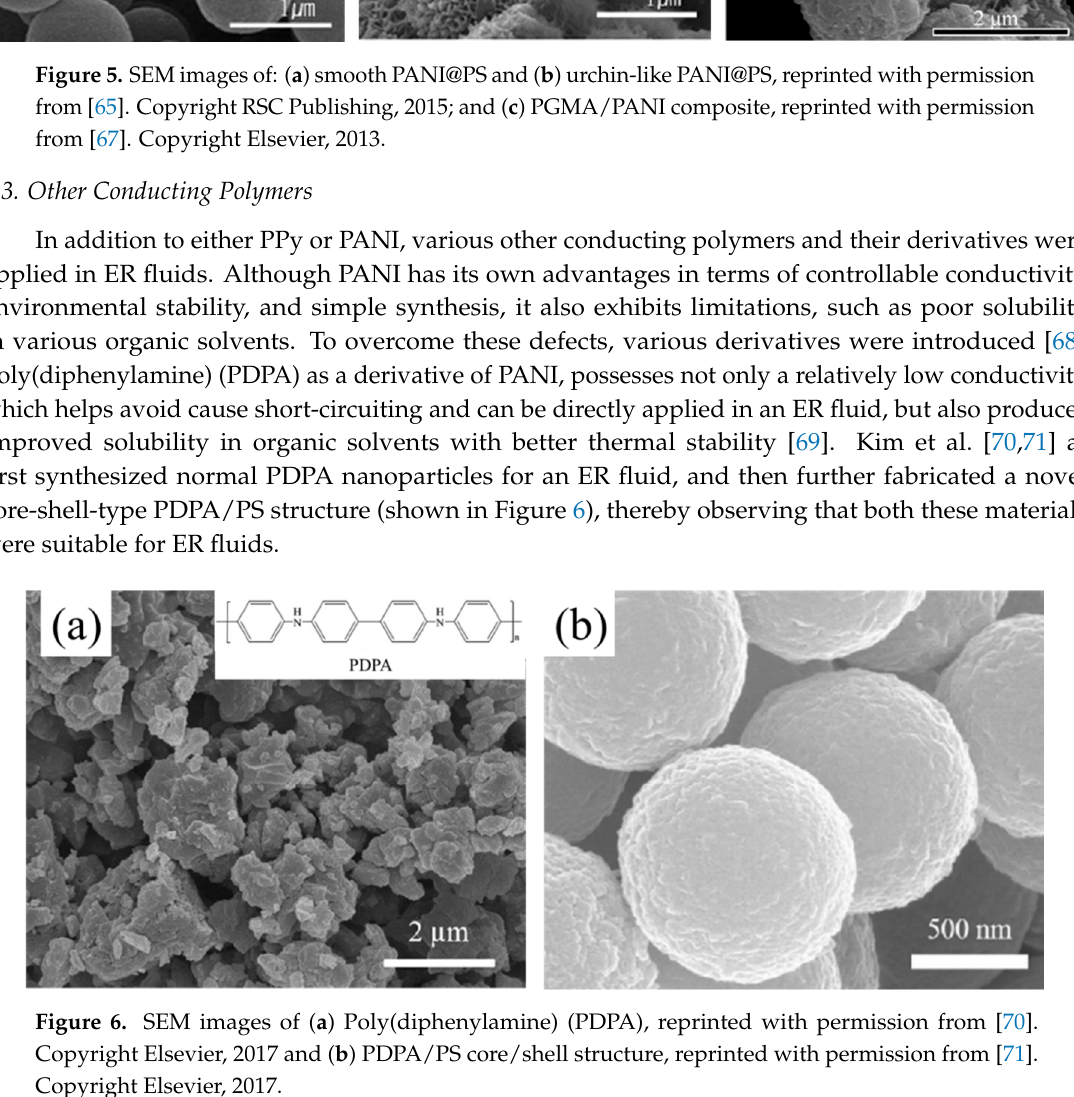
Figure 6. SEM images of ( a ) Poly(diphenylamine) (PDPA), reprinted with permission from [70].